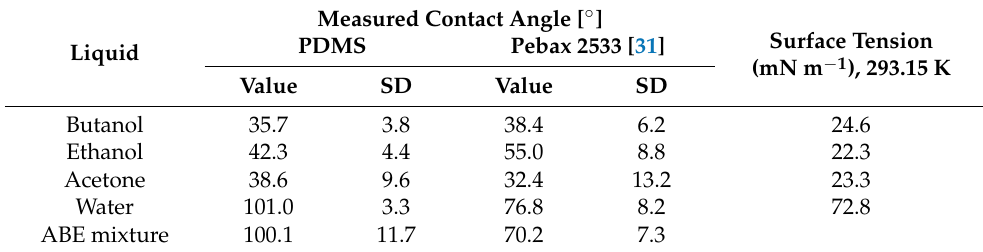
Table 2. Contact angle measured for selective polymers and ABE